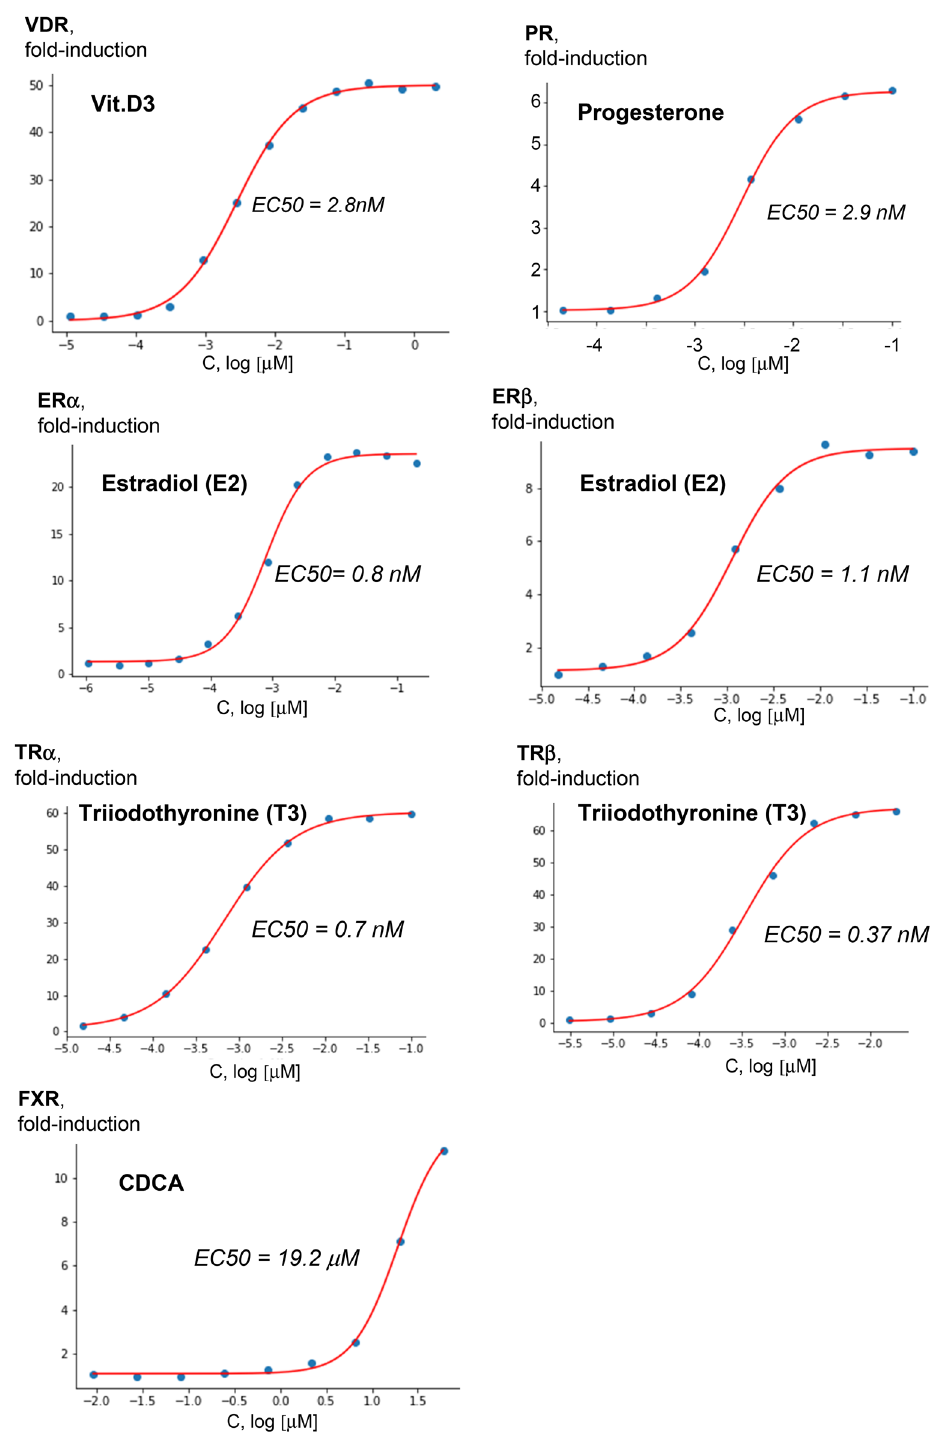
Figure 3. Assessing the EC50 values for ligand-receptor interactions. The concentration–response values for the ligands were interpolated by the Hill equation. The inferred EC50 values are average values of three independent FACTORIAL NR